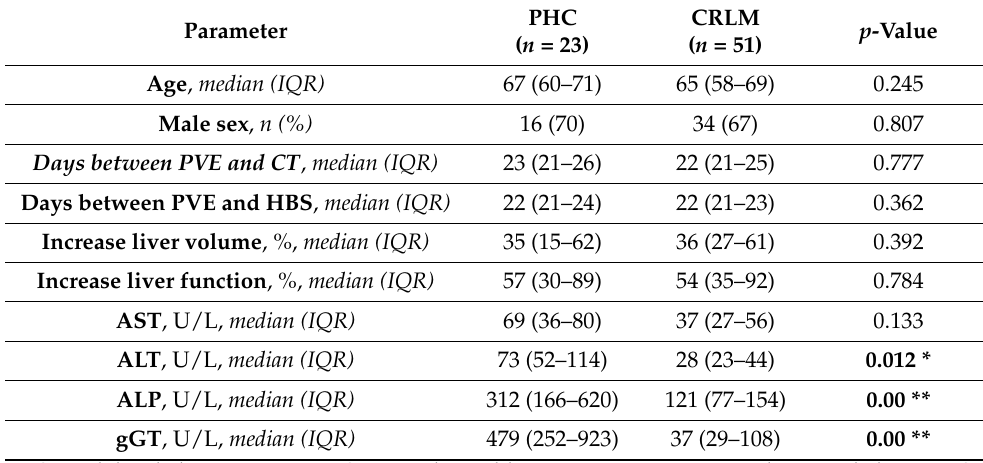
Table 1. Comparison of increases in future remnant liver volume and function after portal vein embolization in patients with perihilar cholangiocarcinoma and colorectal liver